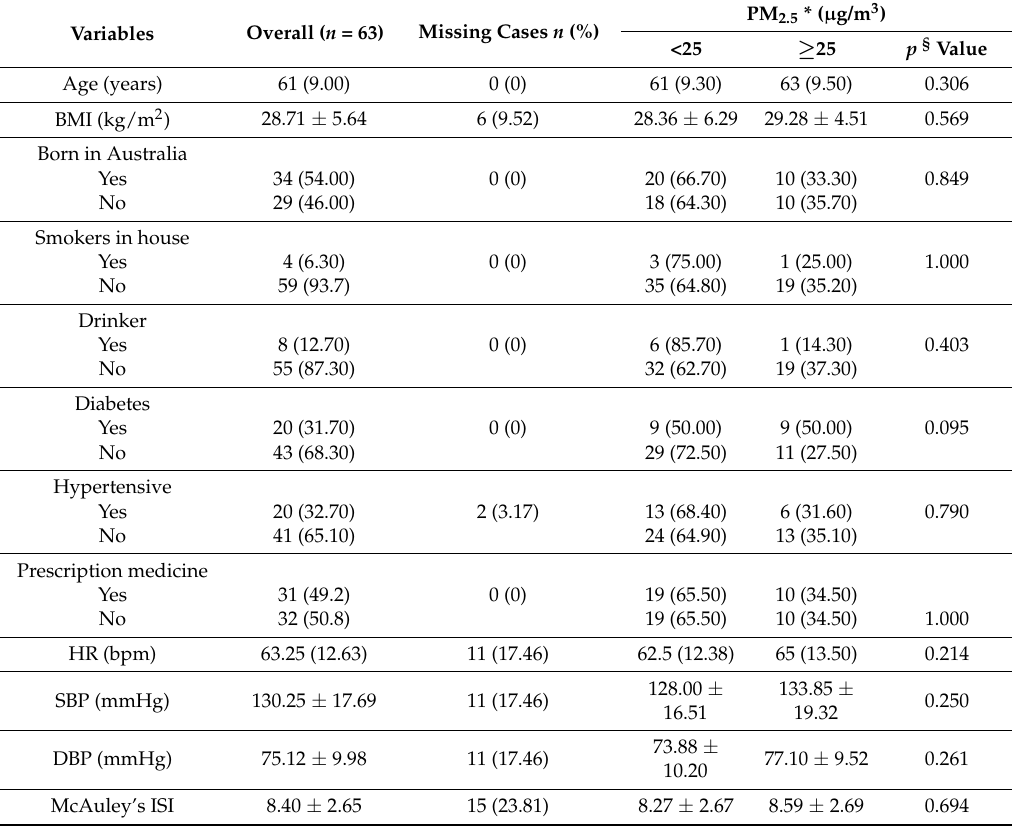
Table 1. Summary of participants by indoor PM 2.5 concentration (based on all subjects n = 63).